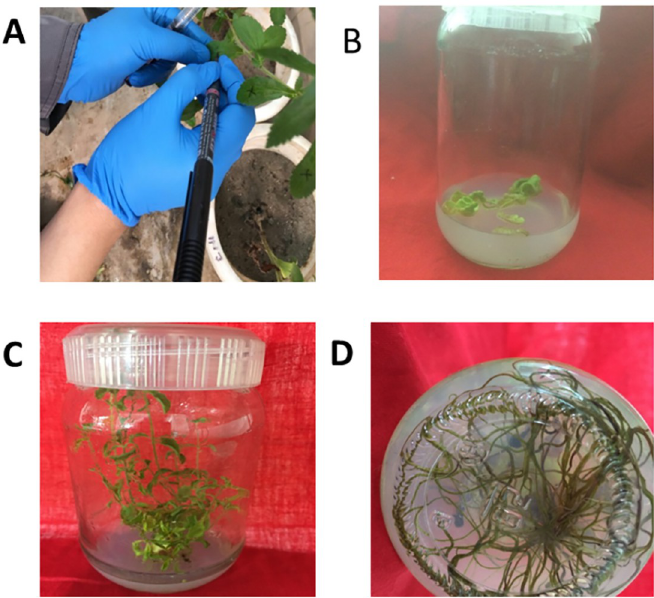
Fig 5. In vitro culture of Stevia rebaudiana A: Transiently transfored leaves B: Transiently transformed leaves cultured on SISM (shoot induction selection medium) (MS basal medium + 1.5mg/L BAP + 0.05mg/L NAA + 10mg/L kanamycin) C: Multiple shoots on SISM And D: Roots on MS basal medium.